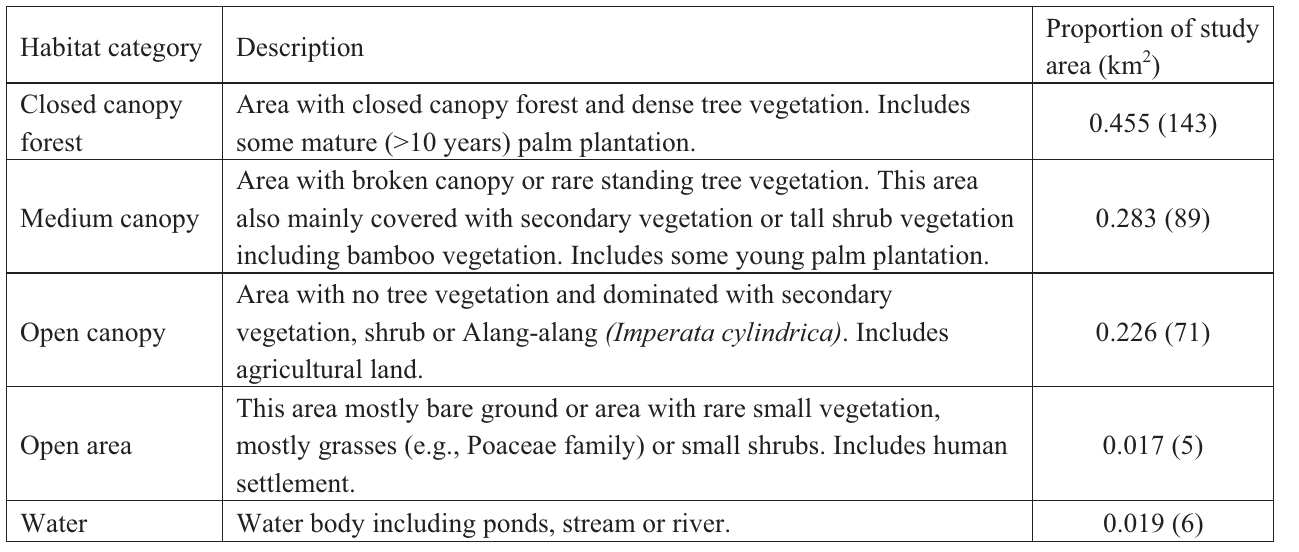
Table 1. Habitat descriptions and abundance in the elephant study area at